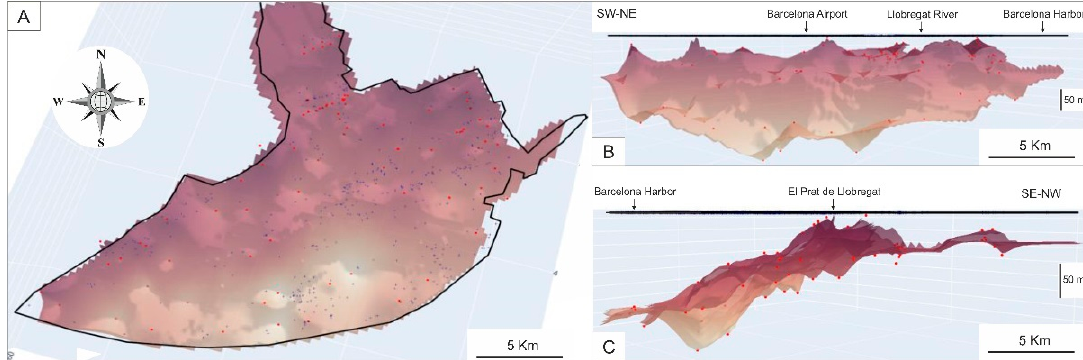
Figure 10. Zenithal ( A ), SE–NW frontal ( B ) and NE–SW lateral ( C ) views of the LRD basement top surface. The plotting adopted a 1:1:50 (x = 2, y = 2 and z = 0.5) aspect ratio for better display. The brown scale varies from light to dark tones for the shallower and deeper basement occurrences, respectively. An interactive 3D HTML version of this model is provided as supplementary material (3D_Basement_LRD.html).